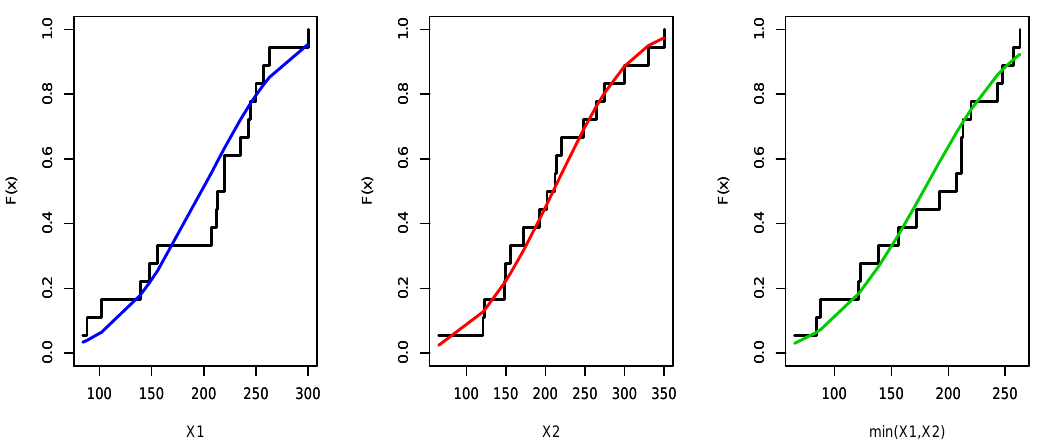
) for data set II. Figure 10. The estimated CDF for X , X 2 1